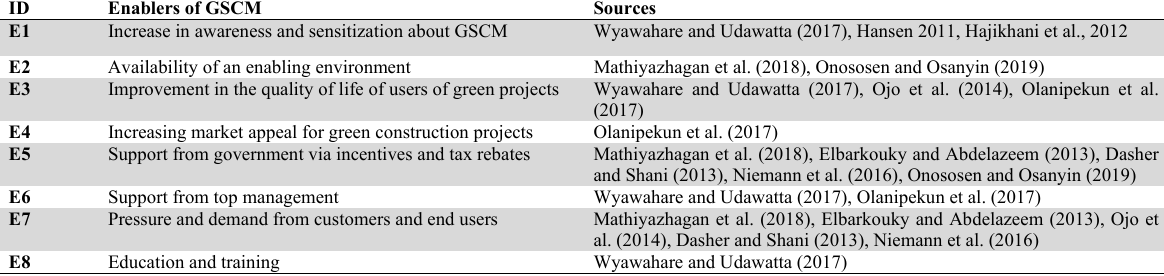
Green Supply Chain Management Enablers